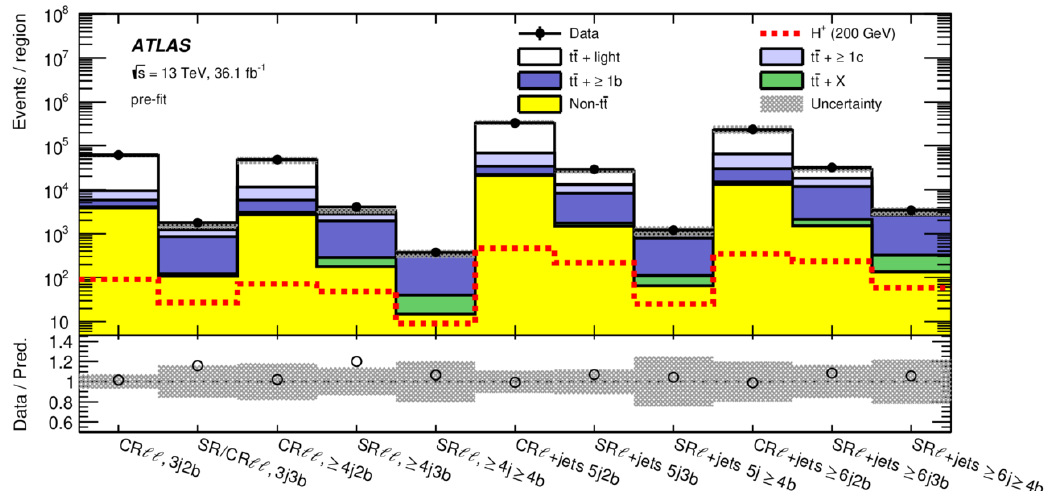
Figure 2. Comparison of predicted and observed event yields. Each background process is nor- malised according to its cross-section and the prediction has not been (cid:12)tted to the data. The t (cid:22) t + X includes contributions from t (cid:22) tW , t (cid:22) tZ and t (cid:22) tH . A signal with m cross-section times branching ratio for H + ! tb of 1 pb, is shown as a dashed line. The lower panel